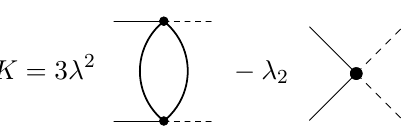
Figure 6 . Graphical representation of the kernel (3.18) of the quartic O ( N ) 3 model. Solid lines represent full two-point functions, while dashed lines represent amputated external